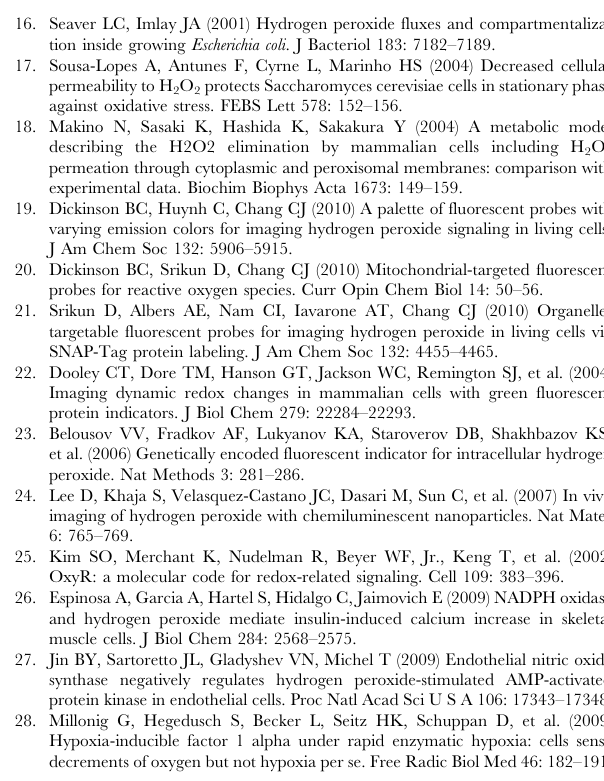
Figure S8 HyPer response to activators of ER stress. HEK293 cells stably expressing HyPer in the ER were treated with 2 m g/ m l tunicamycin, 5 m g/ m l brefeldin A or 2 m M thapsigargin for 6 h. In addition, cells were treated with 1 mM DTT and 100 m M H 2 O 2 to determine the range of oxidation states of HyPer in cells. Data represent mean of 3 measurements, 6 standard deviation. Table S1 Primers used to create constructs expressing HyPer targeted to various cellular compartments. Table S2 Redox state of HyPer in various cellular compart- ments of HEK 293